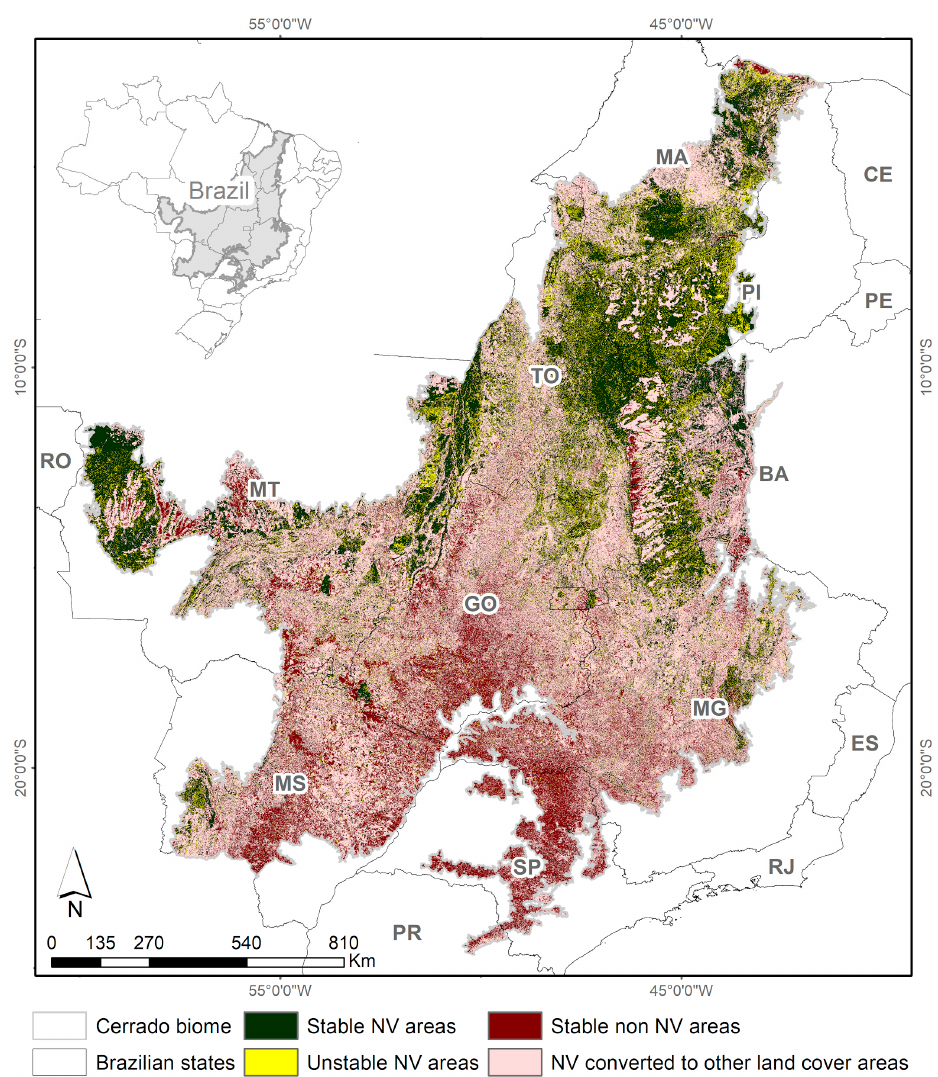
Figure 8. Analysis of stability of native vegetation (NV) and other non-NV classes in the Brazilian Cerrado from 1985 to 2017, presenting stable NV and non-NV areas, as well as the unstable areas that either changed to other NV classes or to other non-NV land cover classes. Table 5. Out of the area classified as native vegetation (NV) in 2017, the total area that did not change class (stable), the total area that changed among other NV classes (natural instability), and the total area that had been previously converted (anthropogenic instability followed by NV recovery).